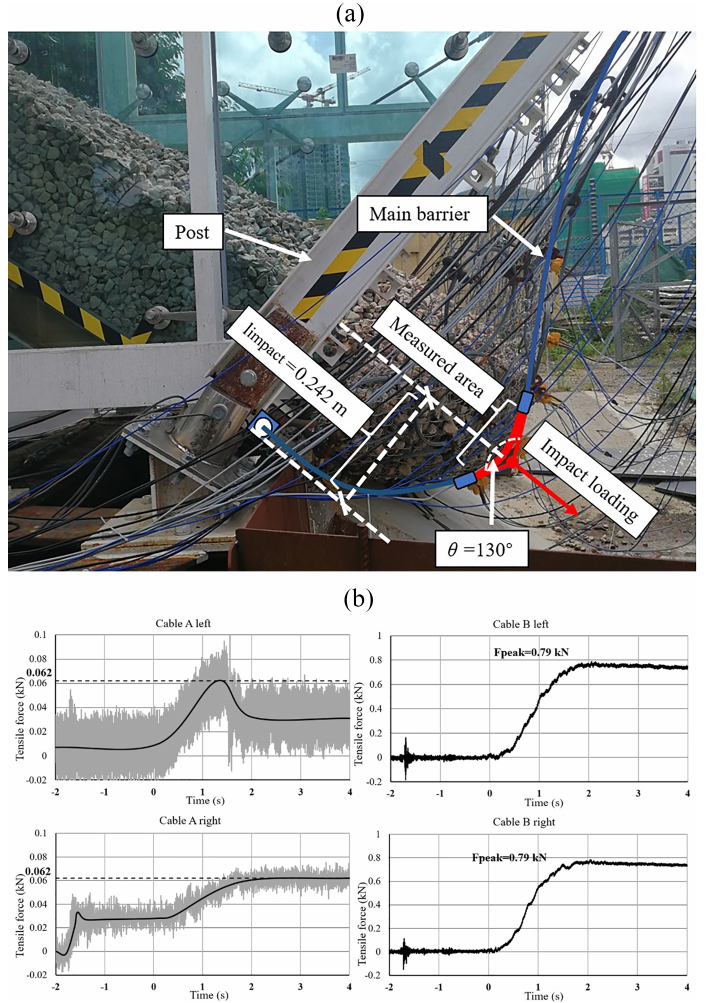
Figure 13. (a) Photograph at the instant of the largest deformation with measured parameters and (b) recorded forces and time by the tension link transducers on the supporting cables in test